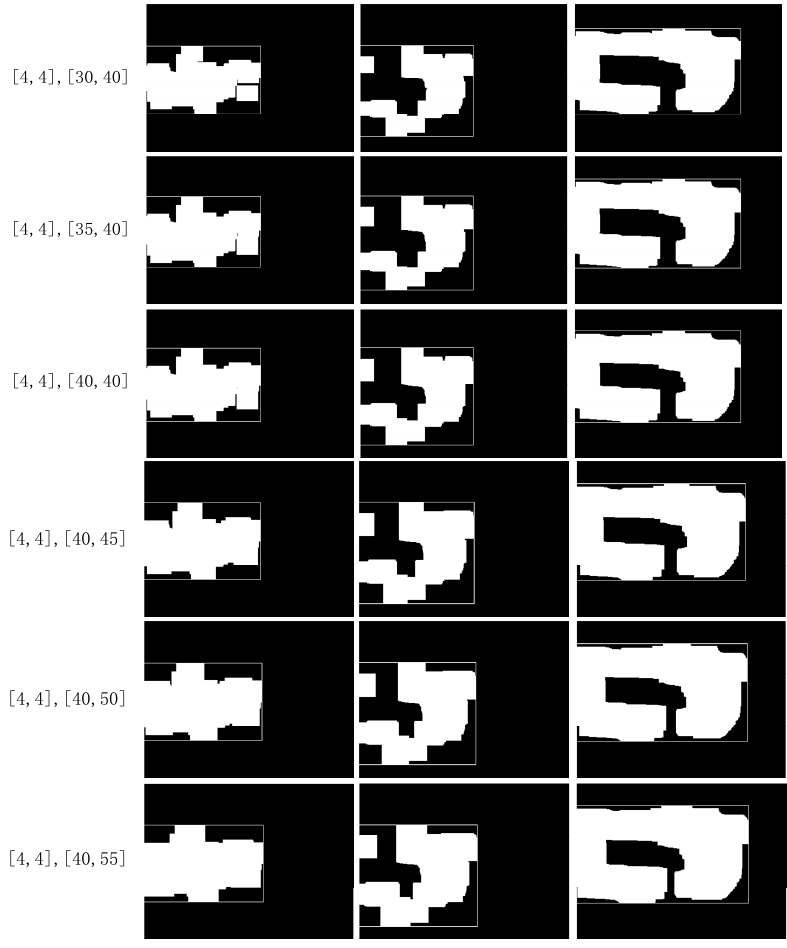
Figure 13. Processing results with different swell structural elements.